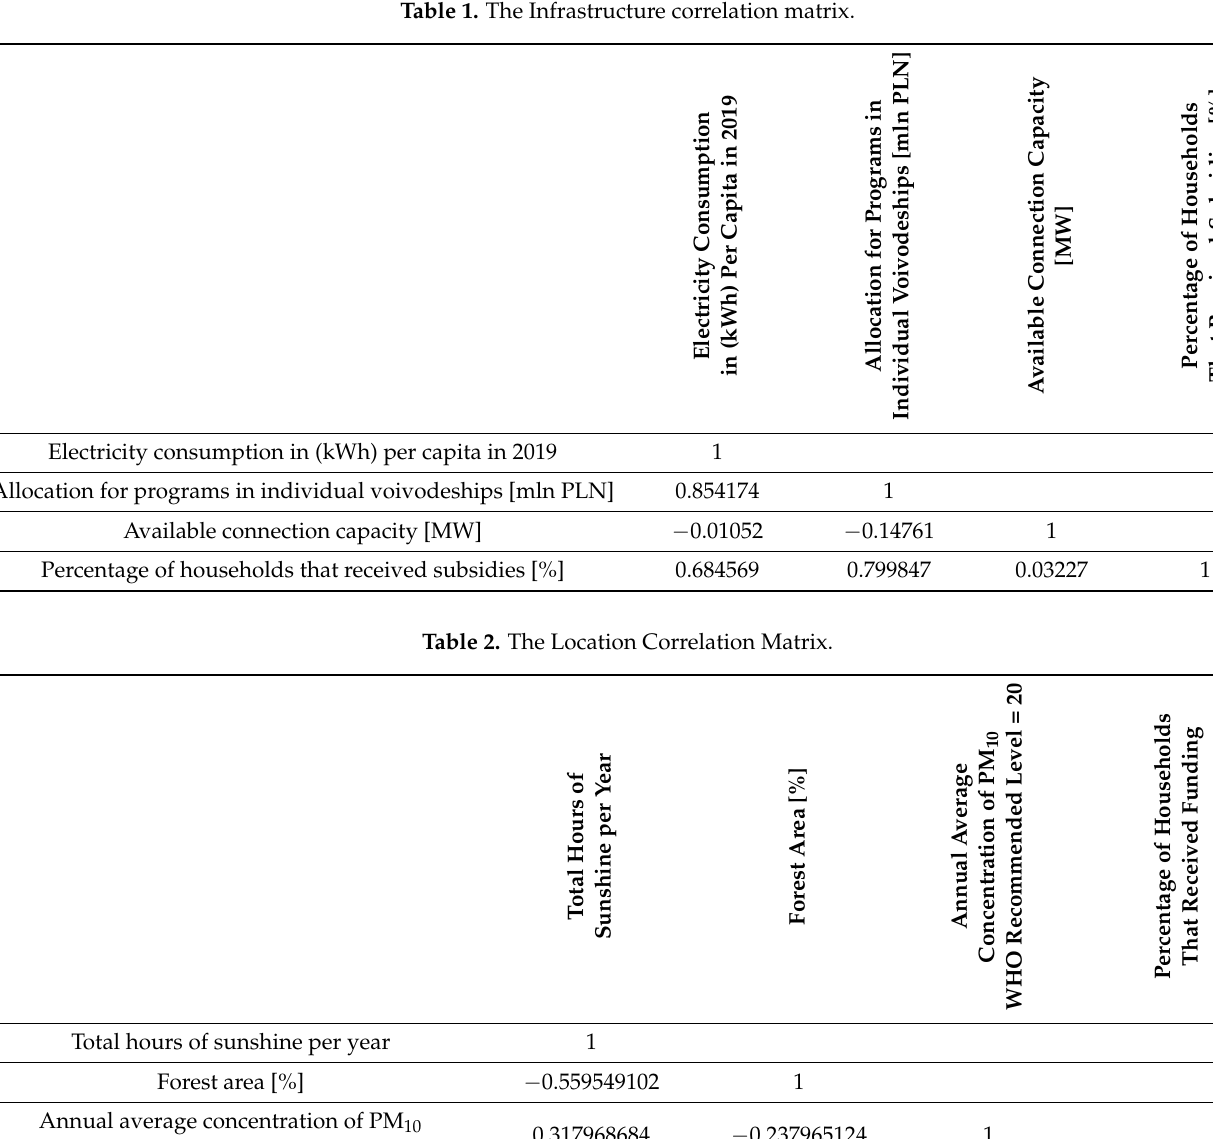
Table 1. The Infrastructure correlation matrix.